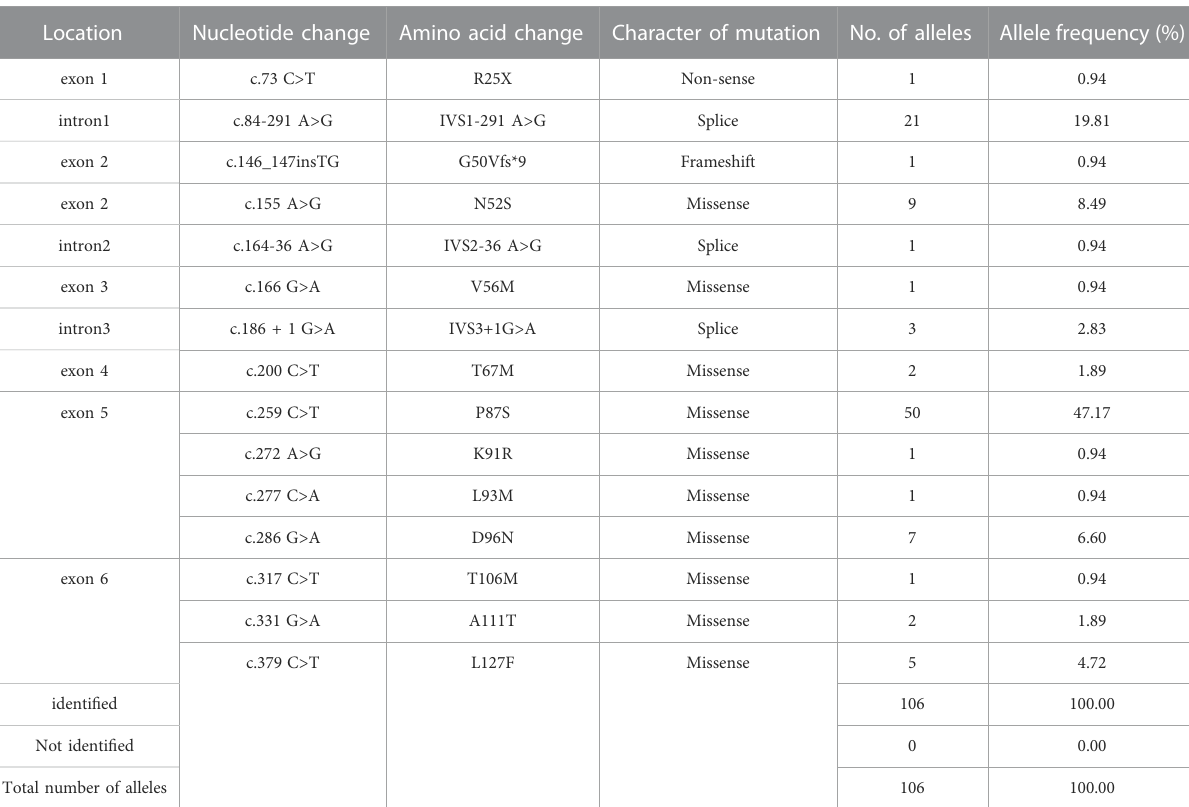
TABLE 1 Genotyping analysis of 53 patients with PTPSD in Jiangxi